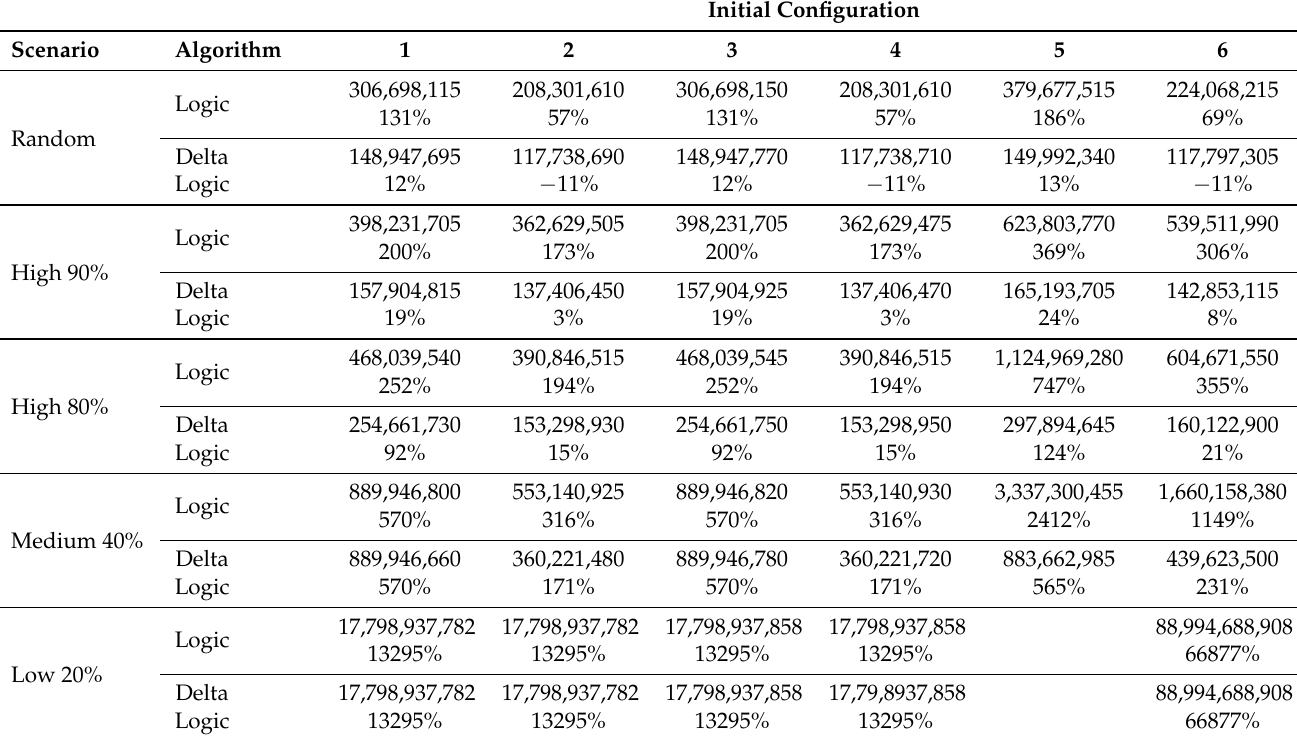
Table 7. Test results compared against the scenario with fixed security. Initial